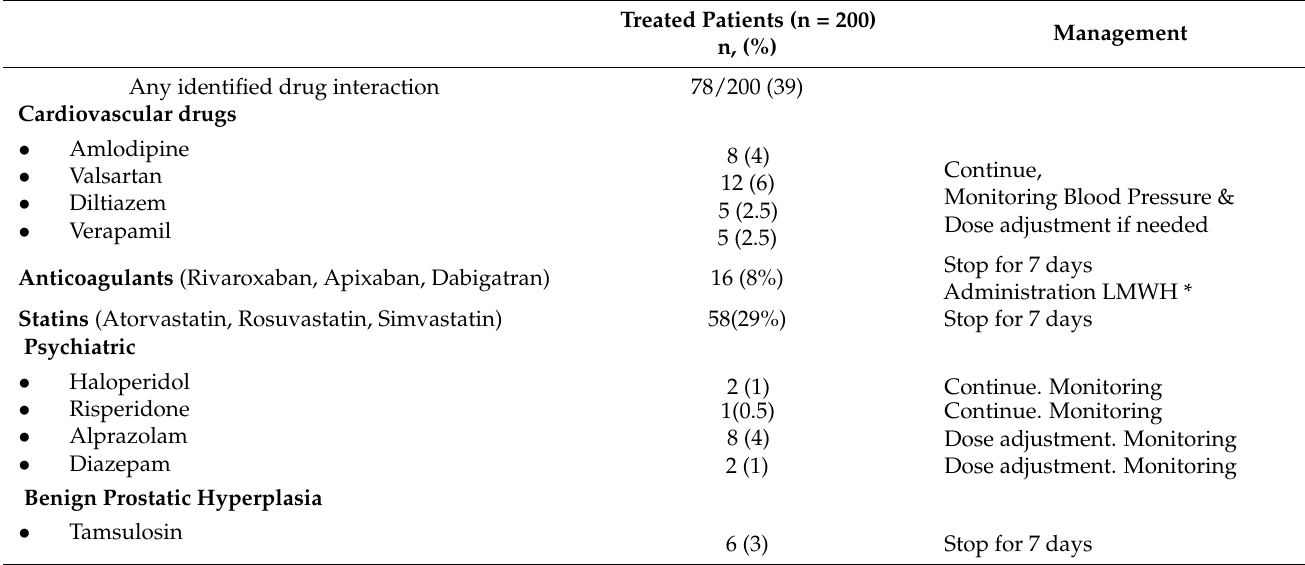
Table 3. Identified drug interactions with concomitant drugs for comorbidities and